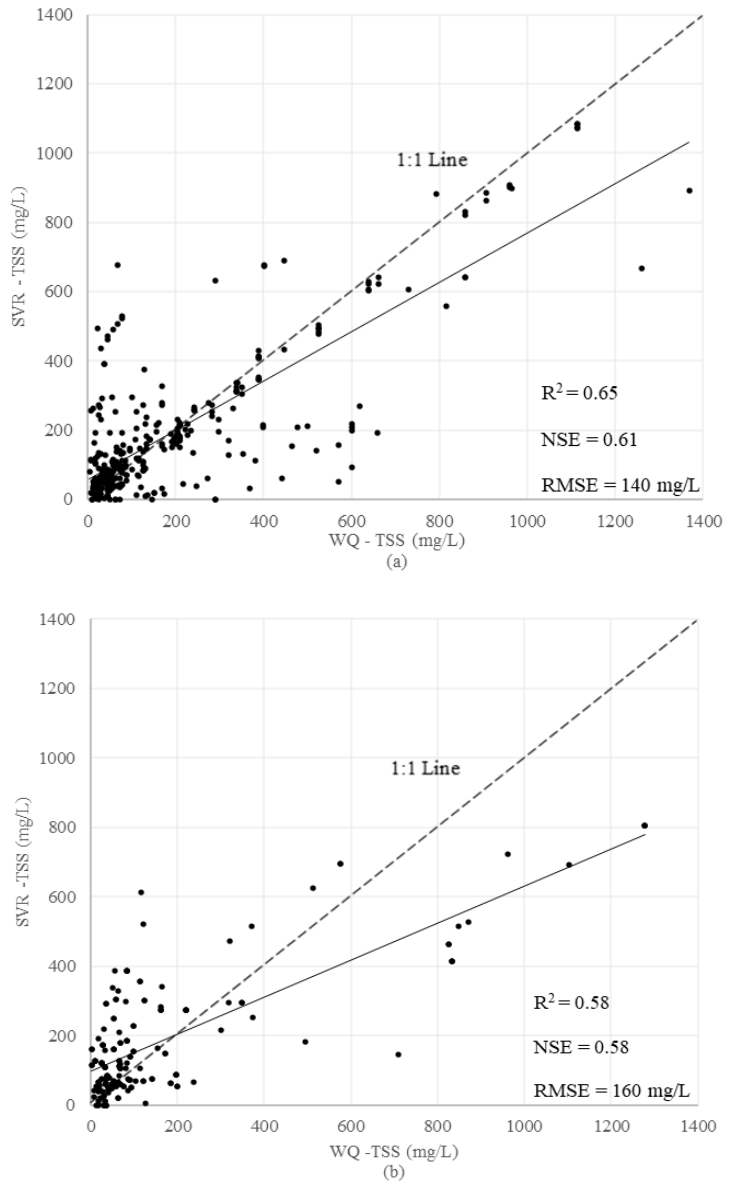
Figure 5. Correlation between the measured values and Support Vector Regression (SVR)-pre- dicted TSS concentration in ( a ) the training step and ( b ) the prediction step. TSS concentration in ( a ) the training step and ( b ) the prediction